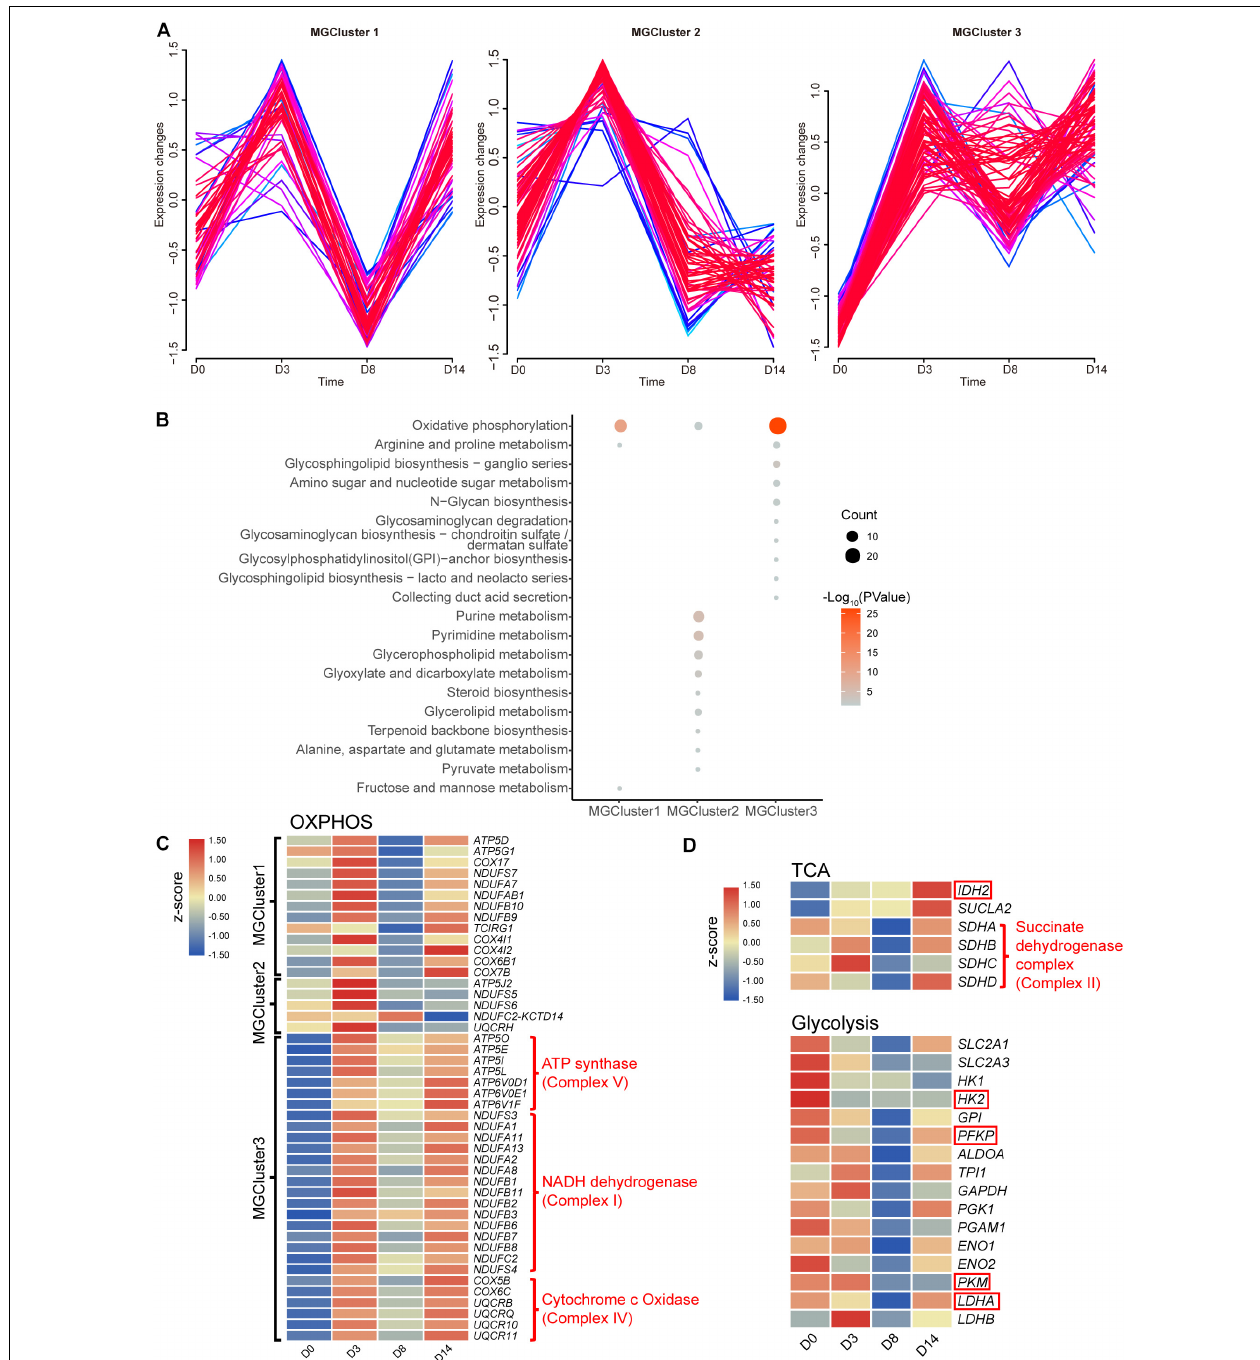
FIGURE 3 | Dynamic changes in metabolite-related genes. (A) Time-course expression profiles of 190 genes enriched in the KEGG term metabolic pathways. (B) KEGG functional analysis of three overrepresented clusters. Pathways with a P -value below 0.05 are shown. (C) Heatmap of relative gene expression related to OXPHOS from three overrepresented clusters. (D) Heatmap of relative gene expression in the TCA cycle related to OXPHOS and in the glycolysis pathway. Genes highlighted in the red frame encoding the rate-limiting enzymes. Heatmap shows averaged values from biological replicates.